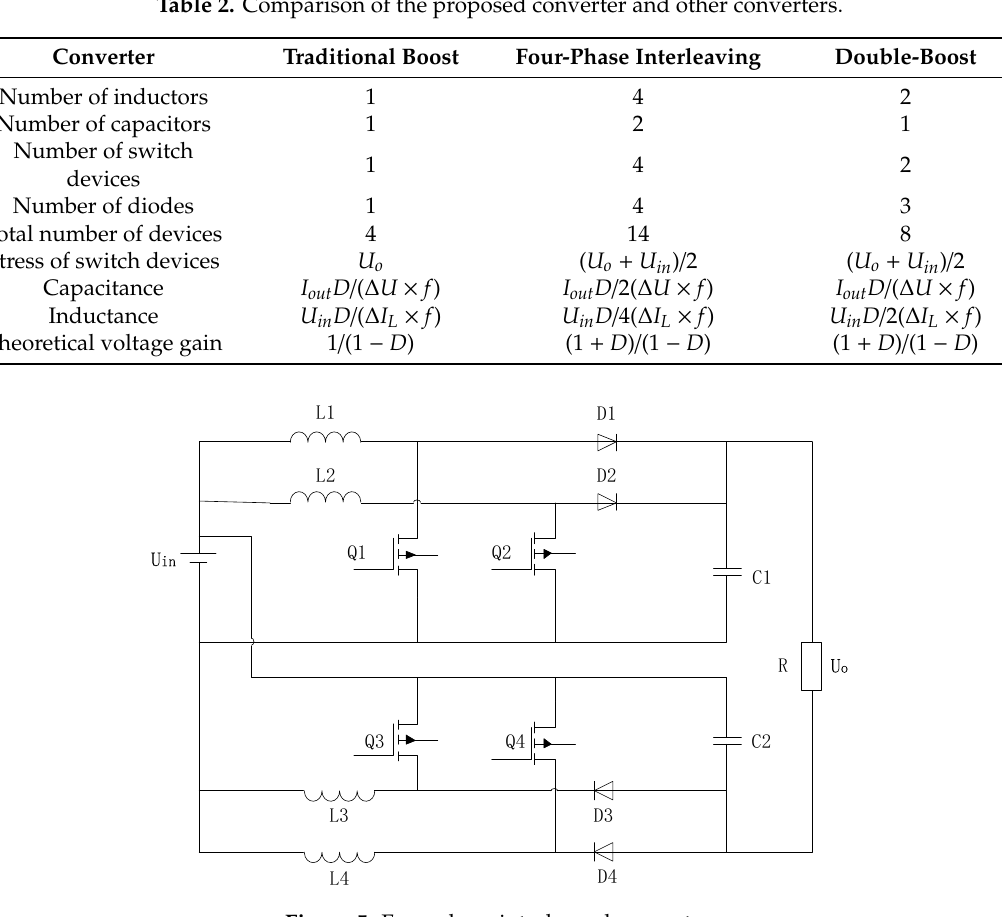
Figure 5. Four-phase interleaved converter. Table 2. Comparison of the proposed converter and other converters.